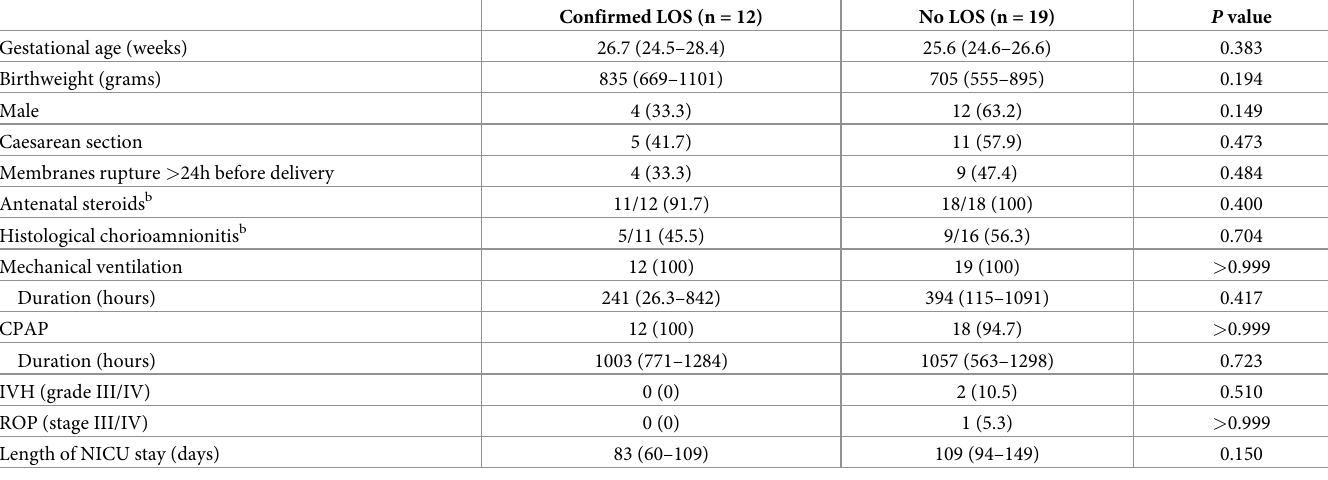
Table 1. Basic demographic and clinical parameters of study cohort a .